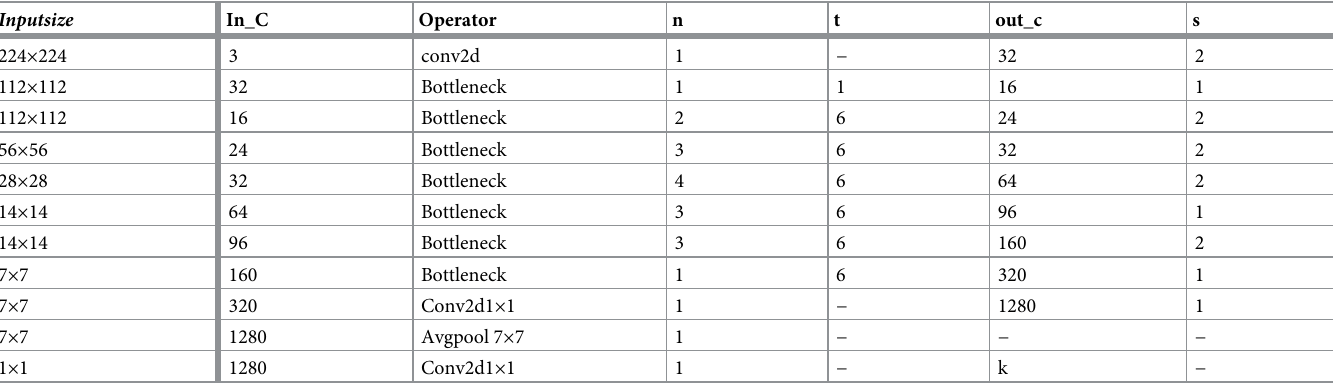
Table 4. The network structure of improved